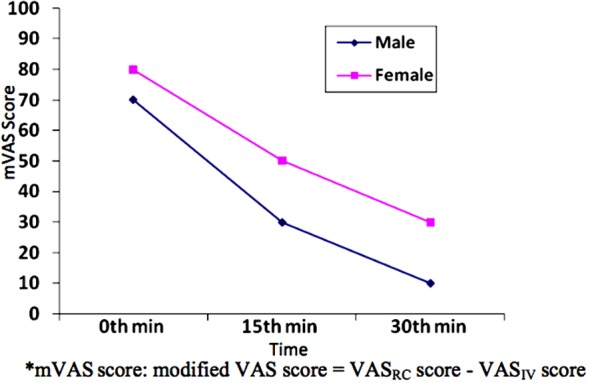
The changes in the mVAS scores for patient group at 0, 15 and 30th min*.